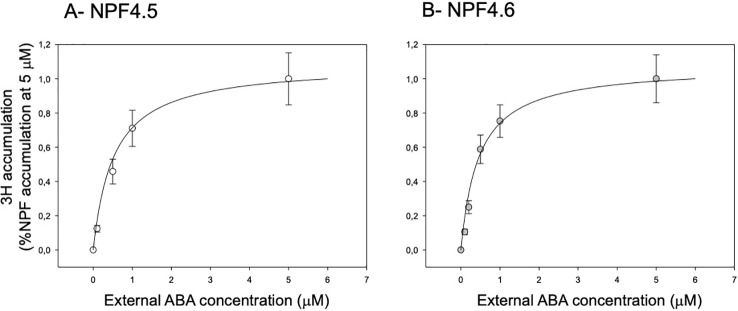
Effect of external ABA concentration on 3H accumulation in NPF4.5 and NPF4.6-expressing oocytes. 3H-accumulation in NPF4.5 (A) and NPF4.6 (B) expressing oocytes depending on the wide external ABA concentrations range (0–5 μM 3H-ABA). The solid lines are least-squares Michaelian fits. Data are mean +/− SE (n = 6–10 oocytes, biological replicates).